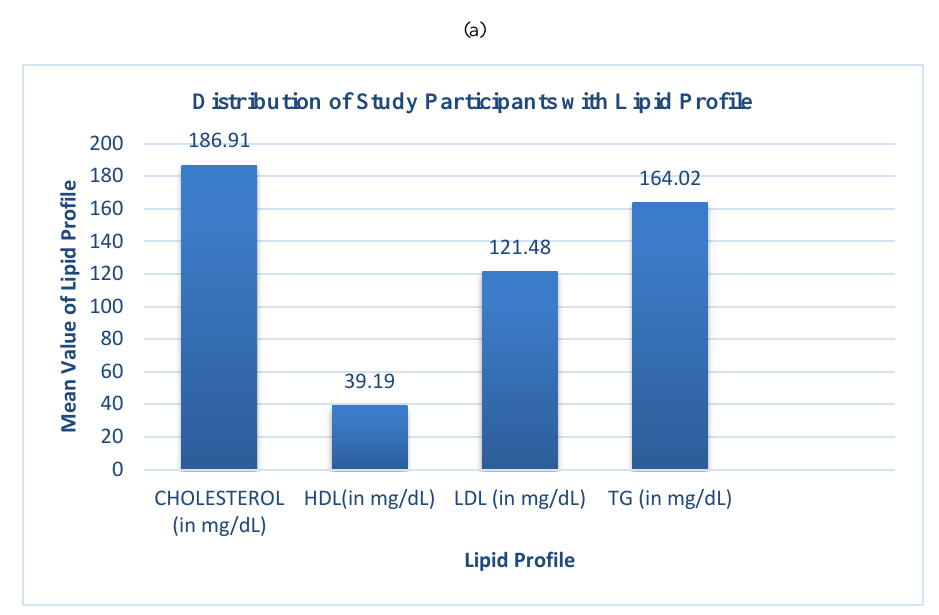
(b) Fig. 3. Distribution of study participants with (a) Blood pressure, (b) lipid